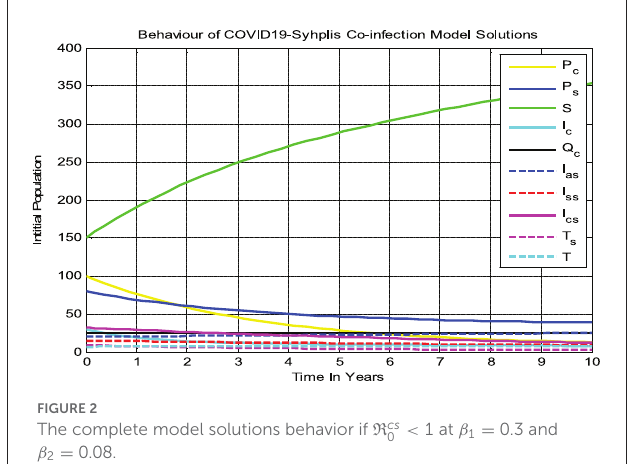
TABLE 4 Sensitivity indexes of R cs 0 = R c 0 .